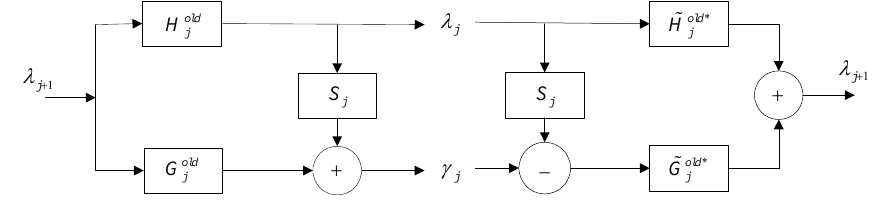
Figure 1. The forward and inverse transform of the lifting